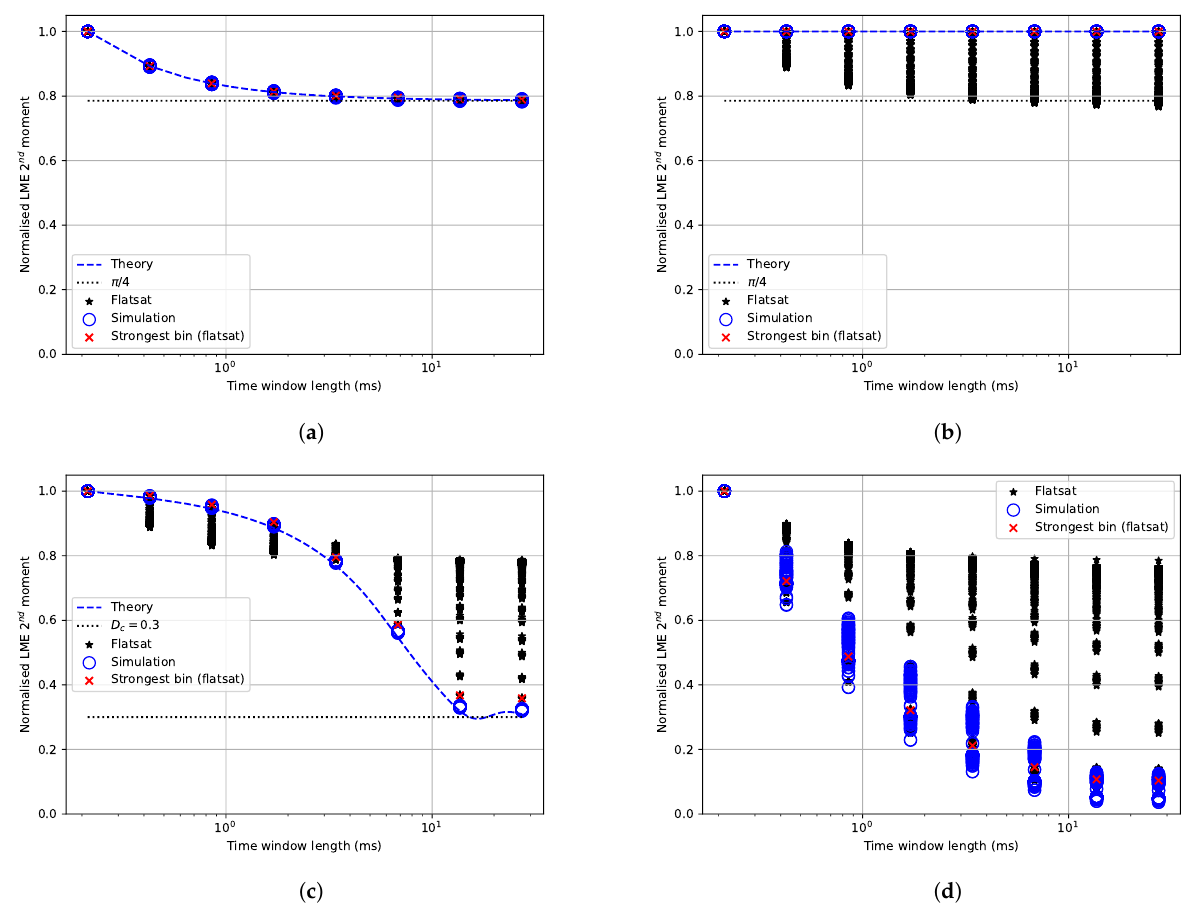
Figure 4. Comparison of the normalised LME second moment in theory, simulations and measurements with the flatsat. The pulse and the chirp signal have a pulse length of 5 s and a period of 16.67 ms. ( a ) Normalised Local Mean Estimator (LME) second moment for AWGN. ( b ) Normalised LME second moment for a CW. ( c ) Normalised LME second moment for a complex pulse. ( d ) Normalised LME second moment for a complex